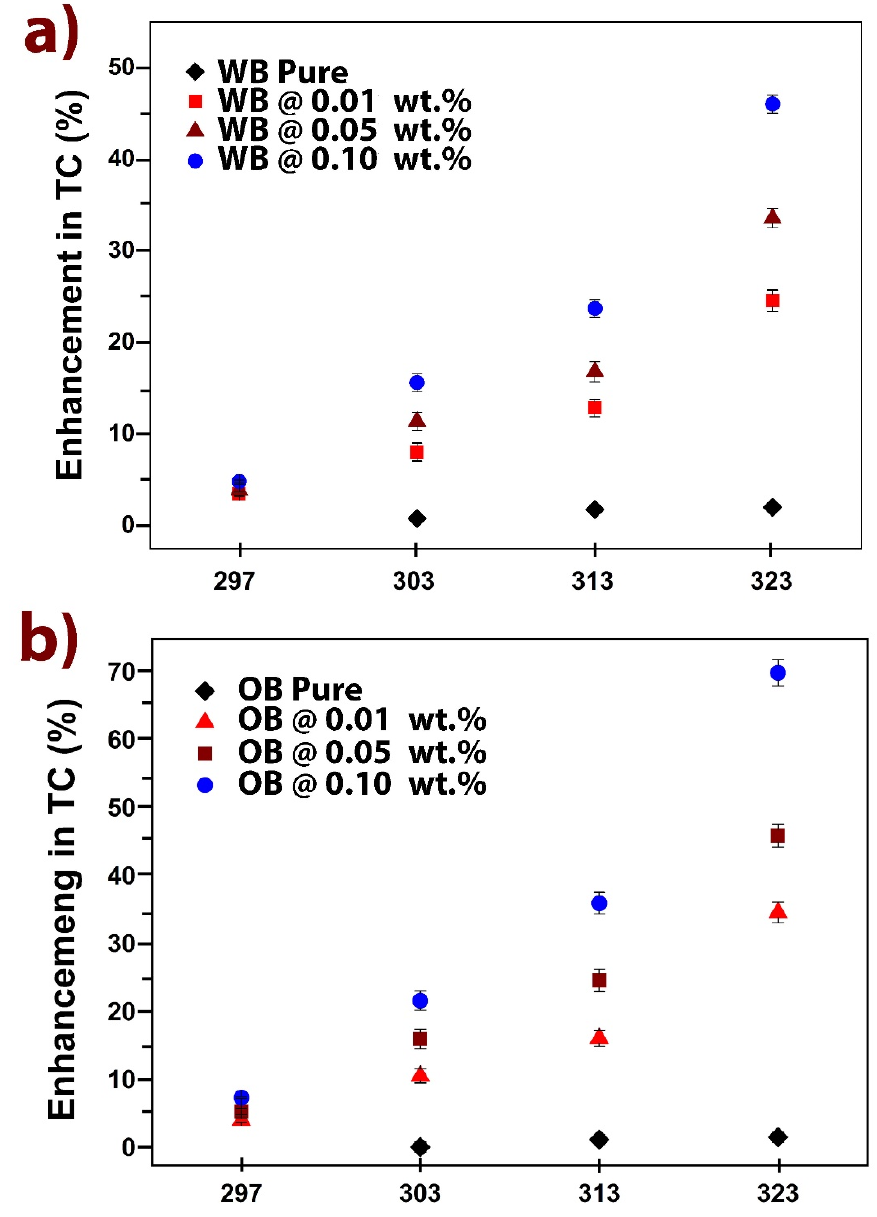
Figure 5. Thermal conductivity enhancements under temperature-dependence evaluation. ( a ) water-based lubricants; ( b ) oil-based lubricants (percentage of filler amount is mentioned). Pure WB lubricant did not show considerable temperature dependency (less than 2%